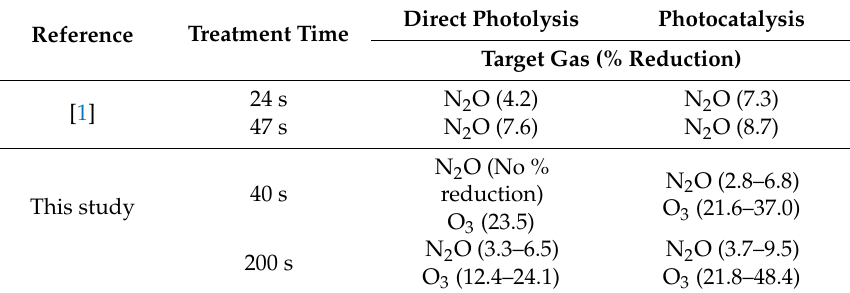
Table 7. Comparison of mitigation of the N 2 O and O 3 in photolysis and photocatalysis.